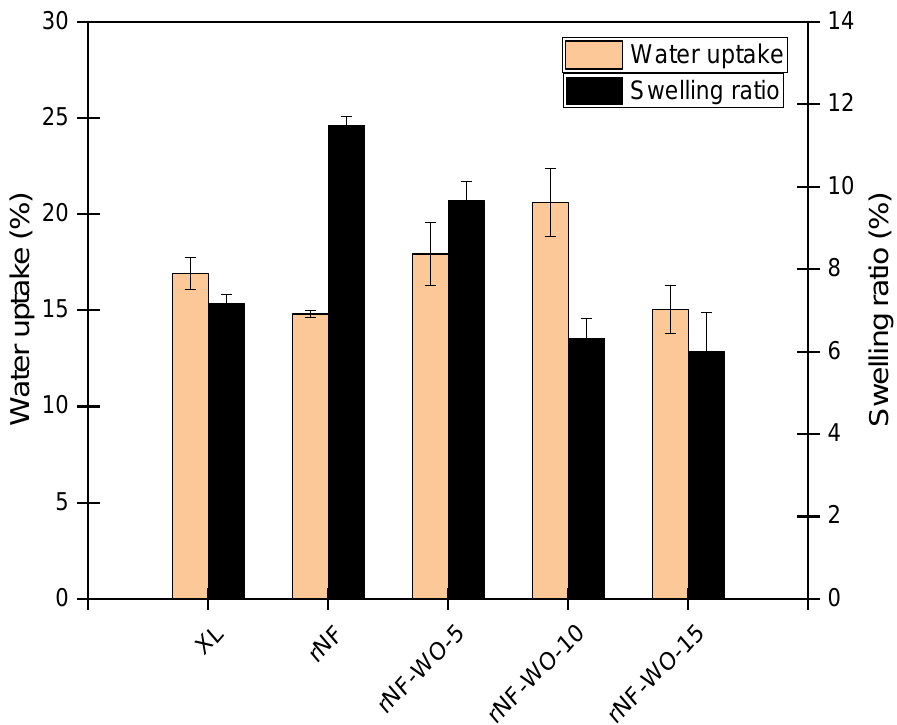
Figure 9. Hydration properties of the commercial, recast, and hybrid Nafion membranes.